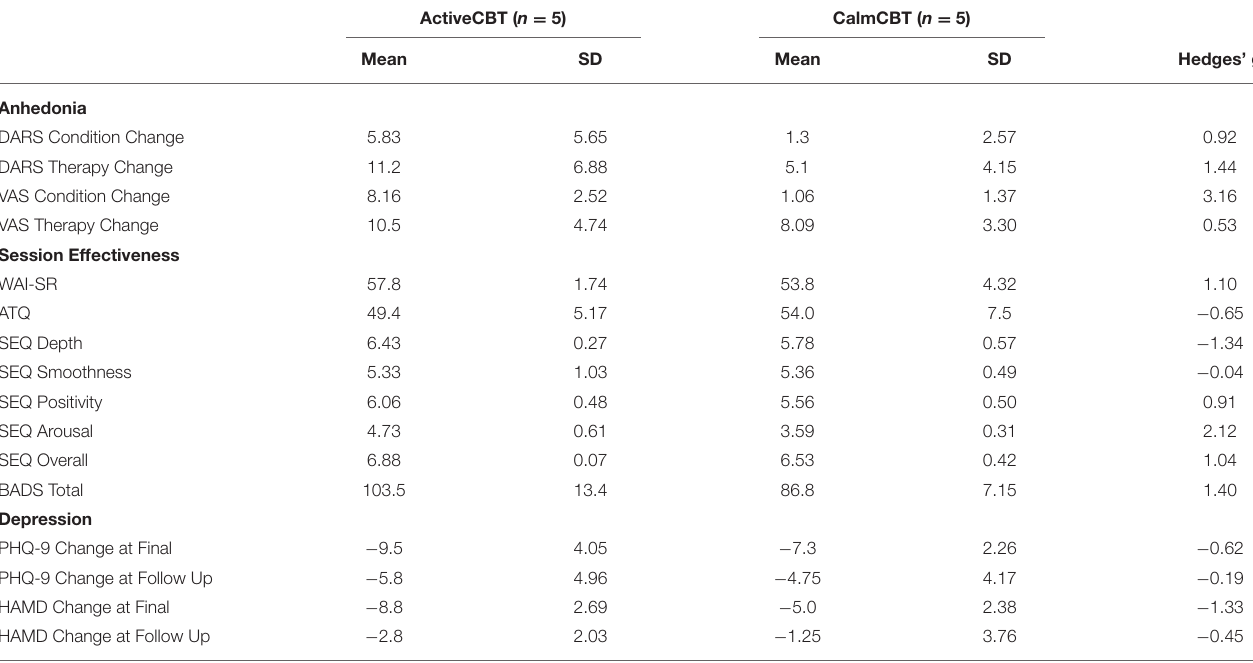
TABLE 4 | Estimated mean and standard deviation values for changes in anhedonia, session effectiveness, and overall depression outcomes across the intervention and 3-month